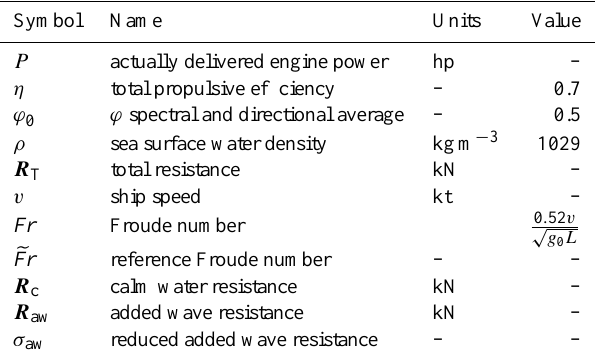
Table 4. Parameters of the ship model. The numerical factor in the formula for Fr value accounts for the conversion of speed v from kt to ms − 1 ; g 0 9 . 80665 is the standard gravitational acceleration; = The values of η and ϕ 0 are just guesses. The value of ρ is taken from Cessi et al. (2014) The nautical resistances have the dimension of a force and their unit is the kilo-Newton (kN).